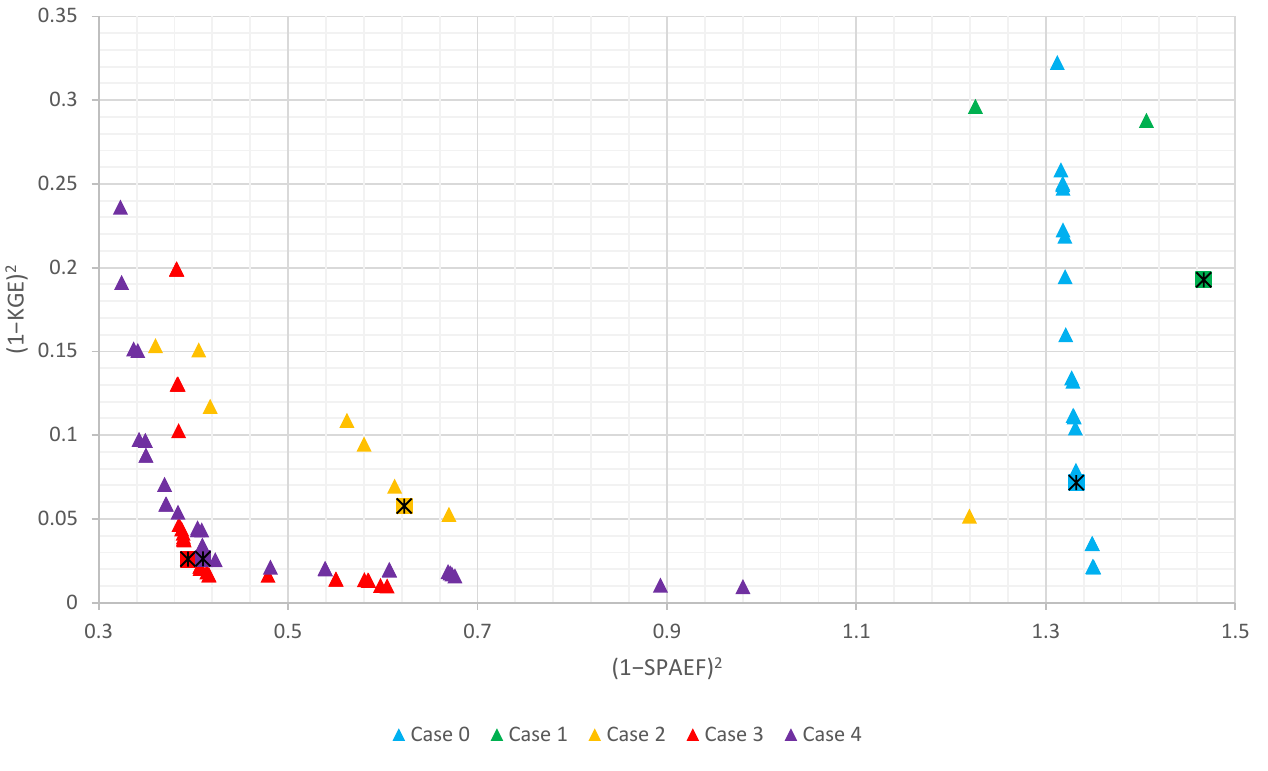
Figure 6. Nondominated results of cases compared with OSTRICH and best result of each case marked.